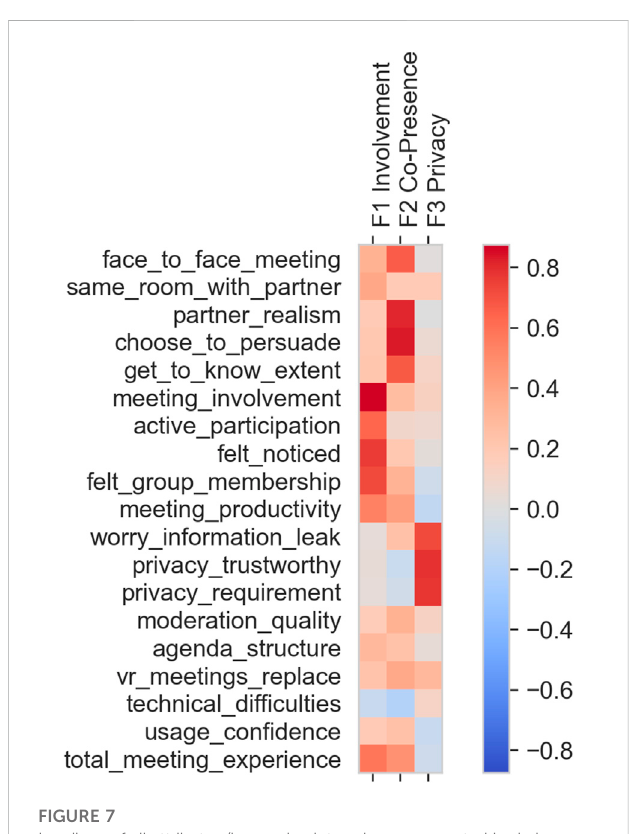
FIGURE 7 Loadings of all attributes (larger absolute values represented in darker colors) for the three factors (F1 – F3) in the exploratory factor